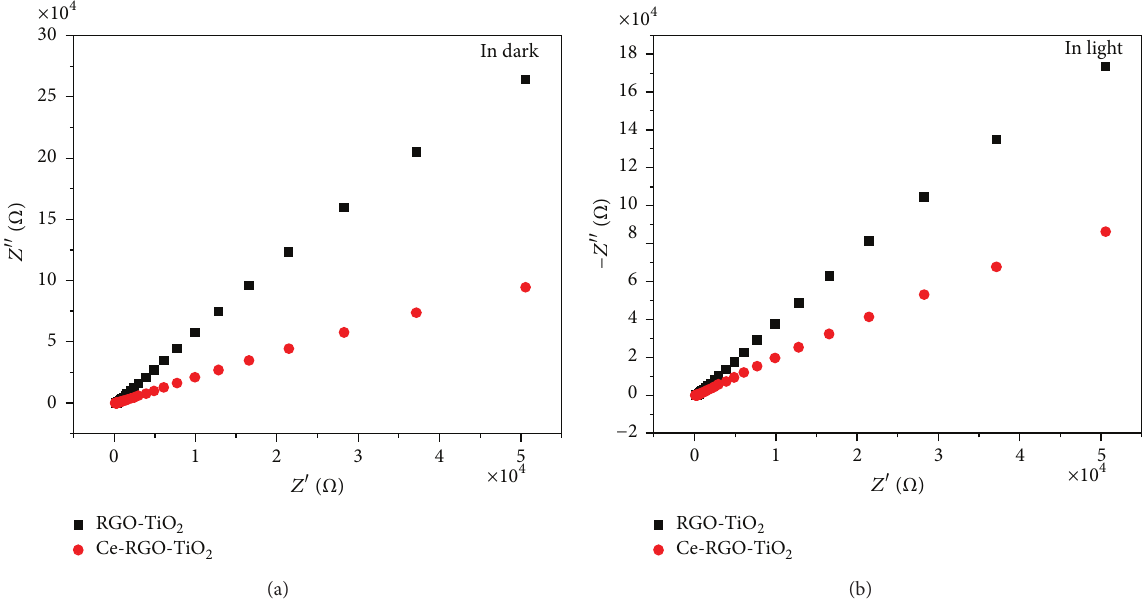
Figure 9: The EIS responses (Nyquist plots) of the RGO-TiO 2 and Ce doped RGO-TiO 2 film electrodes with and without light irradiation at open circuit potential (in dark) and at open circuit potential under visible light irradiation.